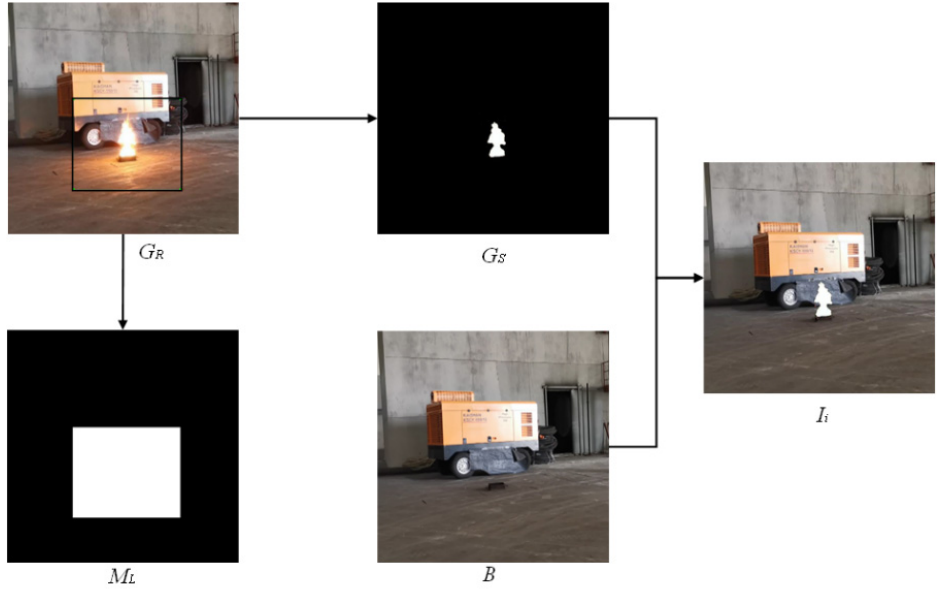
Figure 5. Datasets production process.